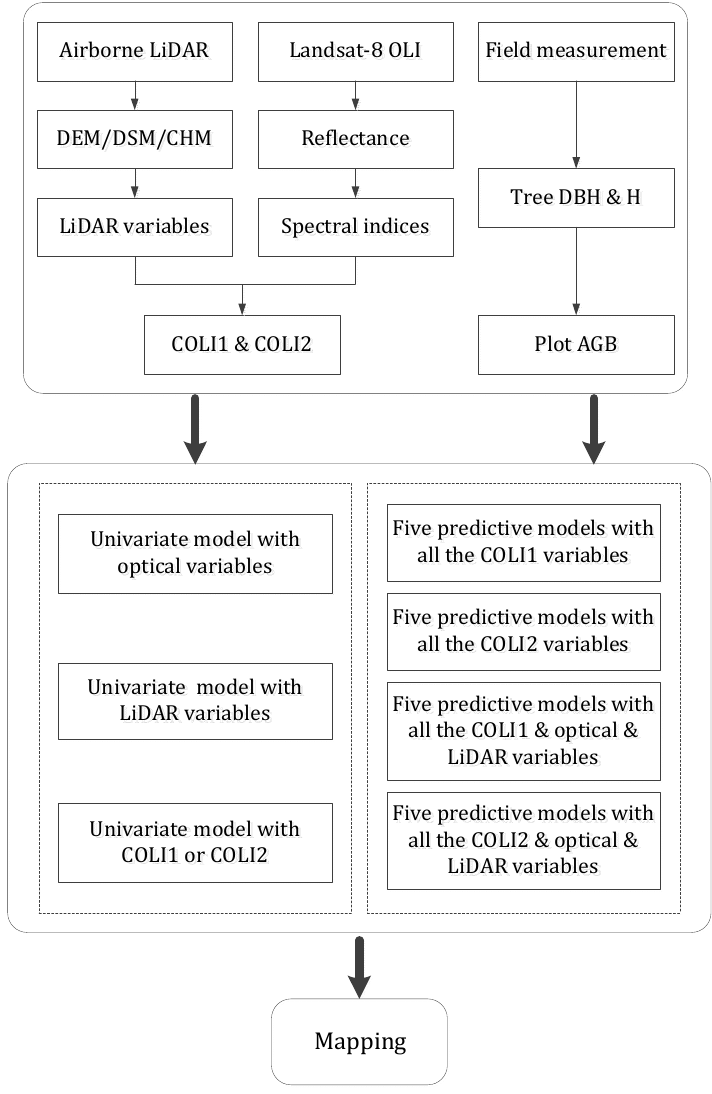
Figure 2. The workflow of the modeling process.